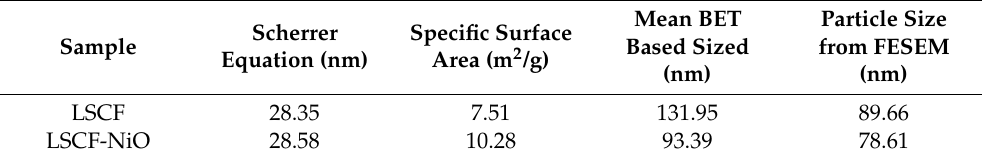
Table 2. Crystallite size, specific surface area, mean BET particle size and average particle size from SEM analysis for bare LSCF and LSCF with 5 wt% of NiO, respectively.